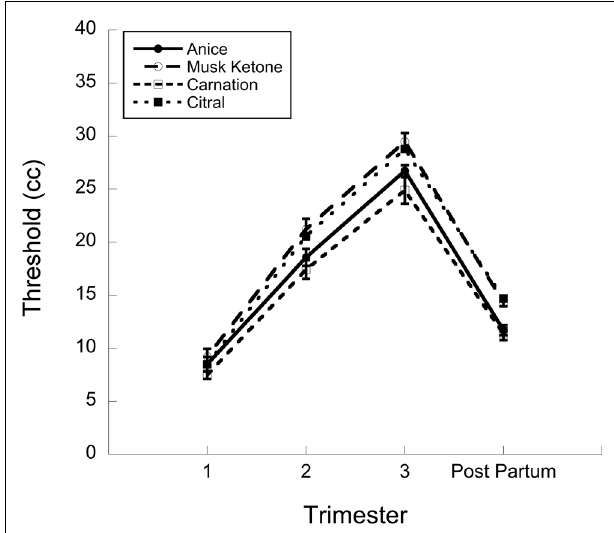
FIGURE 1 | Data from Luvara and Murizi (1961). Threshold (in cubic centimeter, as measured by the blast injection technique) across pregnancy trimester and postpartum.There were a total of 47 participants; 14–21 per session and some participated in more than one